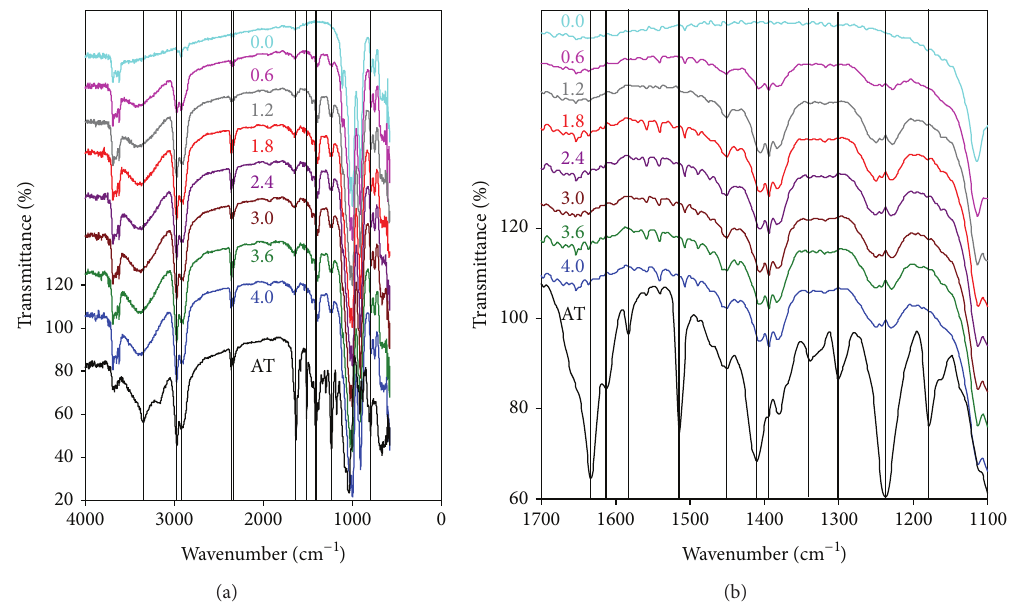
Figure 7: FTIR spectra of crystalline AT, and kaolinite with different amounts of AT adsorption in the ranges of 600–4000 cm −1 (a) and 1100–1700 cm −1 (b). The values indicate initial AT concentrations in mmol/L.